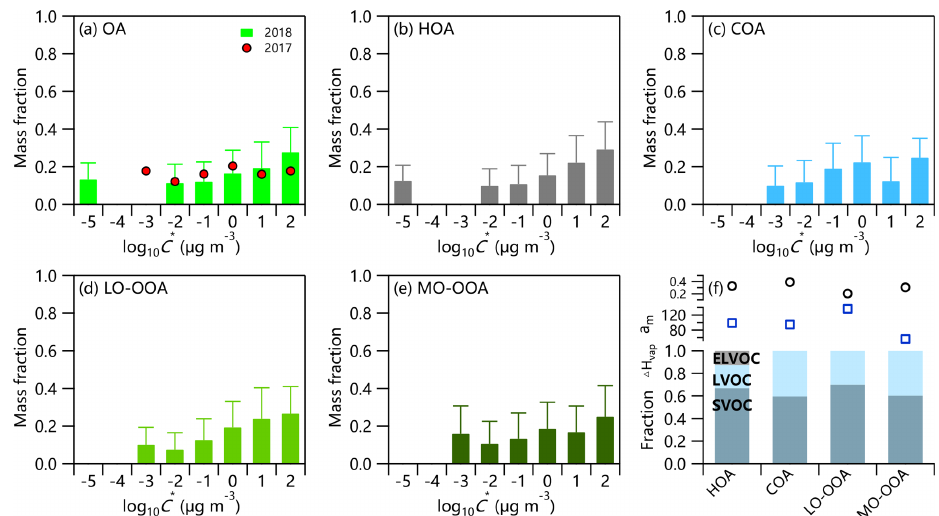
Figure 5. Predicted volatility distributions of OA and four OA factors in 2018. The error bars are the uncertainties derived using the approach of Karnezi et al. (2014). Vaporization enthalpies, accommodation coefficients, and volatility fractions of SVOC and LVOC for four OA factors are shown in (f)